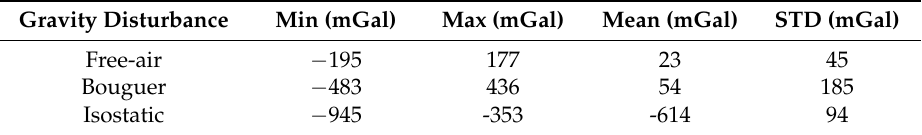
Figure 2. Regional gravity maps: ( a ) the free-air gravity disturbances, ( b ) the Bouguer gravity disturbances, and ( c ) the isostatic gravity disturbances. Table 1. Statistics of the free-air, Bouguer, and isostatic gravity disturbances.